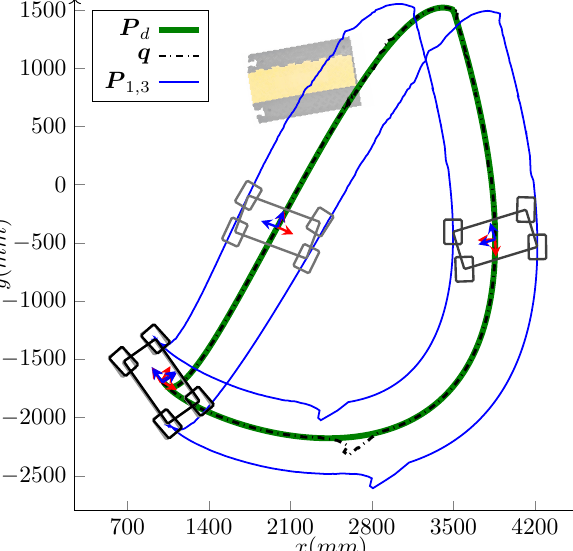
Figure 13. Experiment : The desired path and the localization feedback of the WMR, performing the task shown in Figure 12 (The ramp image is shown for the purpose of clarity and does not represent the exact position of the